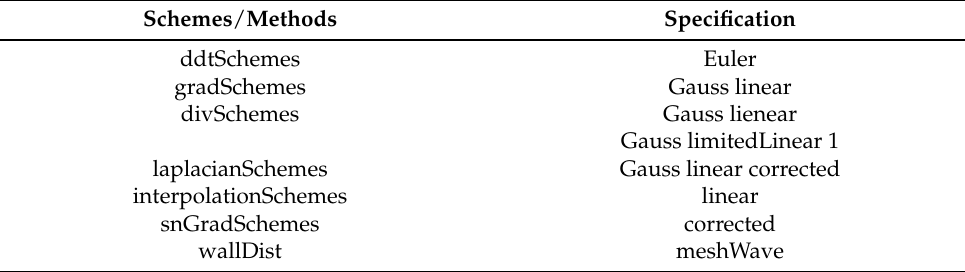
Table 3. Numerical schemes and methods used for the simulations.